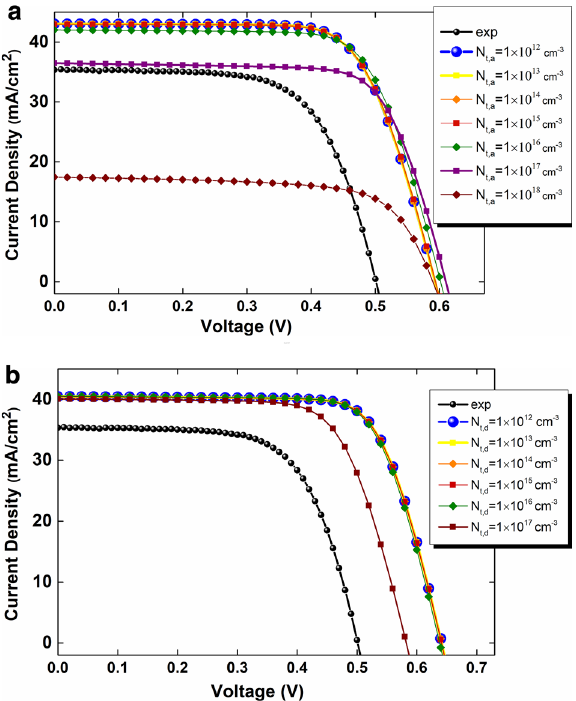
Figure 7. The effect of the absorber bulk defects position on the Current density versus voltage curves in range of ( a ) 1.0 × 10 12 cm −3 to 1.0 × 10 18 cm −3 (acceptor defect density), and ( b ) 1.0 × 10 12 cm −3 to 1.0 × 10 17 cm −3 (donor defect density) (the choice of ranges was based on Density Functional Theory (DFT) calculations 36